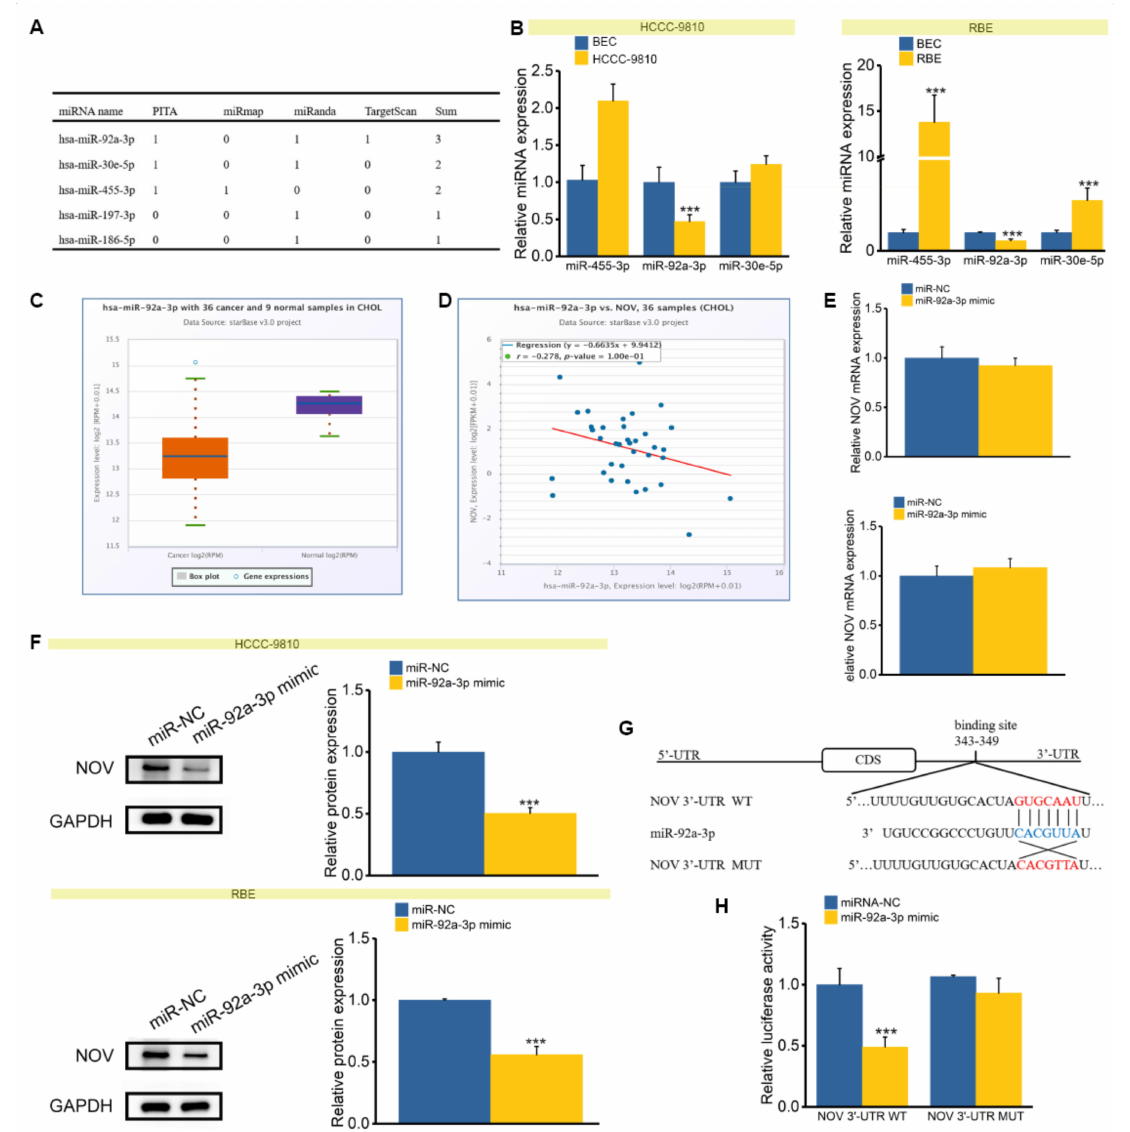
Figure 8. NOV is the direct target of miR-92a-3p. ( A ) Related miRNAs of NOV via different prediction methods. ( B ). Expression levels of miR-92a-3p, miR-30e-5p and miR-455-5p in HCCC-9810 (left) and RBE (right) cells. ( C ) Rela- tive expression level of miR-92a-3p in tumor and adjacent normal samples. ( D ) Expression correlation of miR-92a-3p and NOV. ( E ) The effect of miR-92a-3p on NOV mRNA in HCCC-9810 (left) and RBE (right) cells. ( F ) The effect of miR-92a-3p on NOV protein in HCCC-9810 (up) and RBE (down) cells. ( G ). The binding site of miR-92a-3 and NOV (3 (cid:48) UTR WT and 3 (cid:48) UTR MUT). ( H ) Luciferase activity measurements of WT and MUT after cotransfection of NOV 3 (cid:48) UTR WT or NOV 3 (cid:48) UTR MUT and miR-92a-3p mimic or miR-NC. *** indicates p <